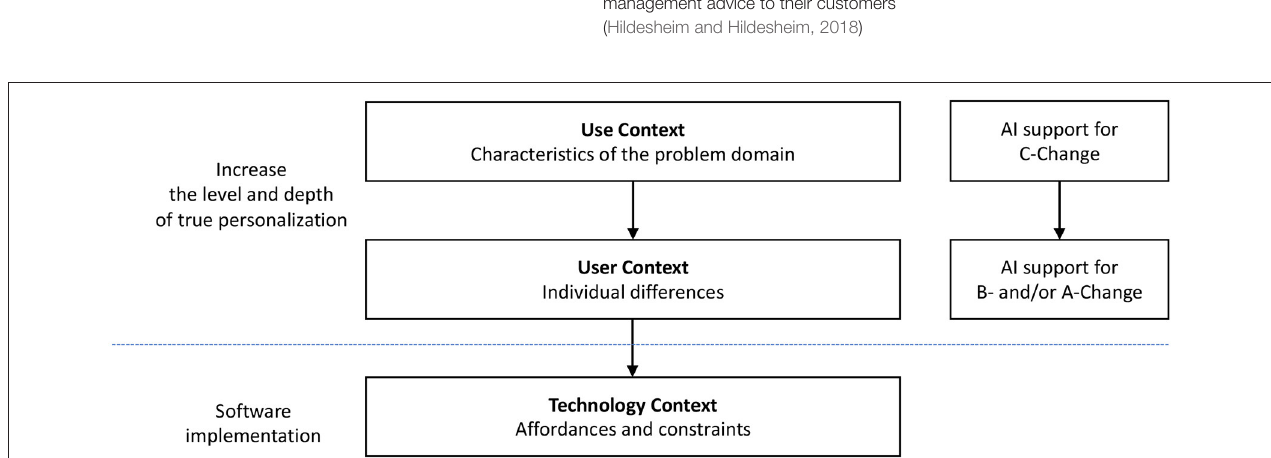
FIGURE 2 | Conceptual AI framework for developing strong